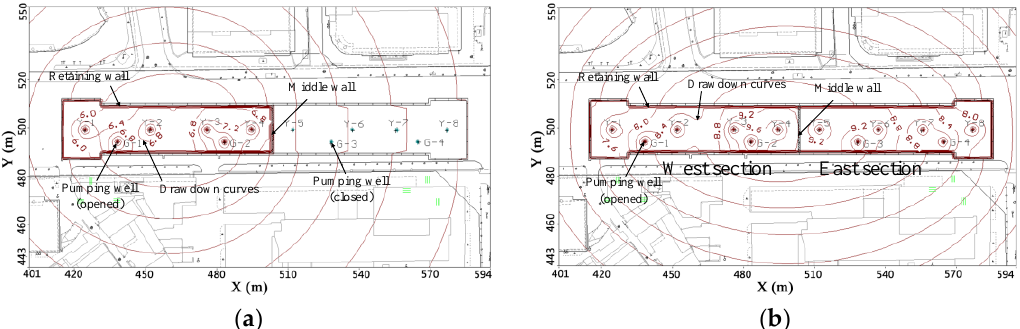
Figure 15. Numerical simulation of the dewatering system: ( a ) West section dewatering; ( b ) overall pit dewatering.